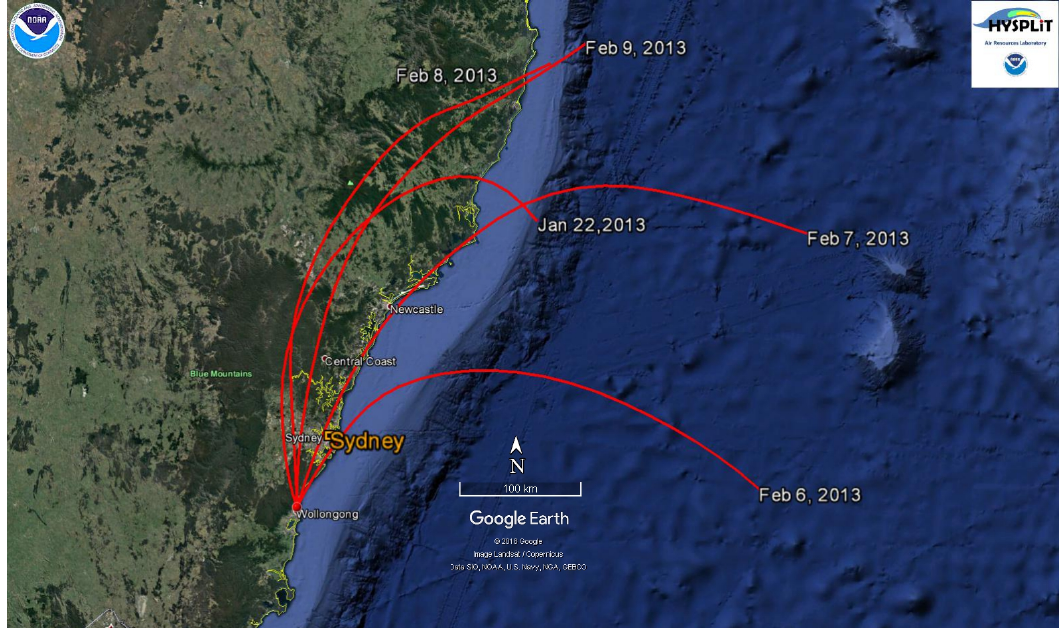
Figure 6. The 24-h backward trajectories produced by HYSPLIT at 100 m above the site for Class I event days (22 January, 6–8 February 2013) and the selected Class II event day (9 February 2013). The monitoring site received the air masses at 10:00 AEST (+10 UTC). Generated in Google Earth R (cid:13) .